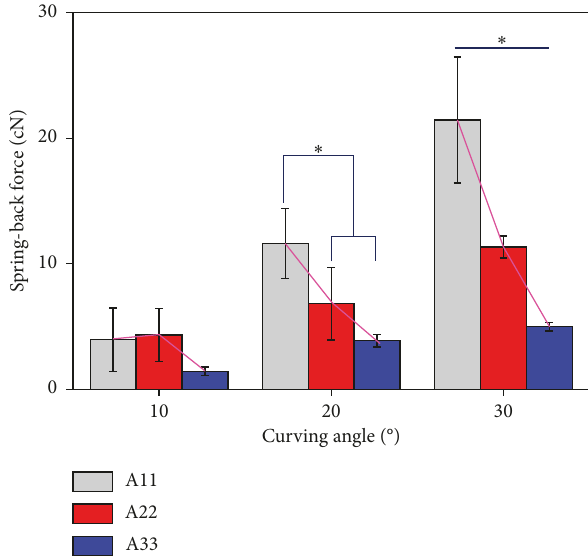
Figure 10: Spring-back force of stent grafts B13 and B23 given the same curving angle.